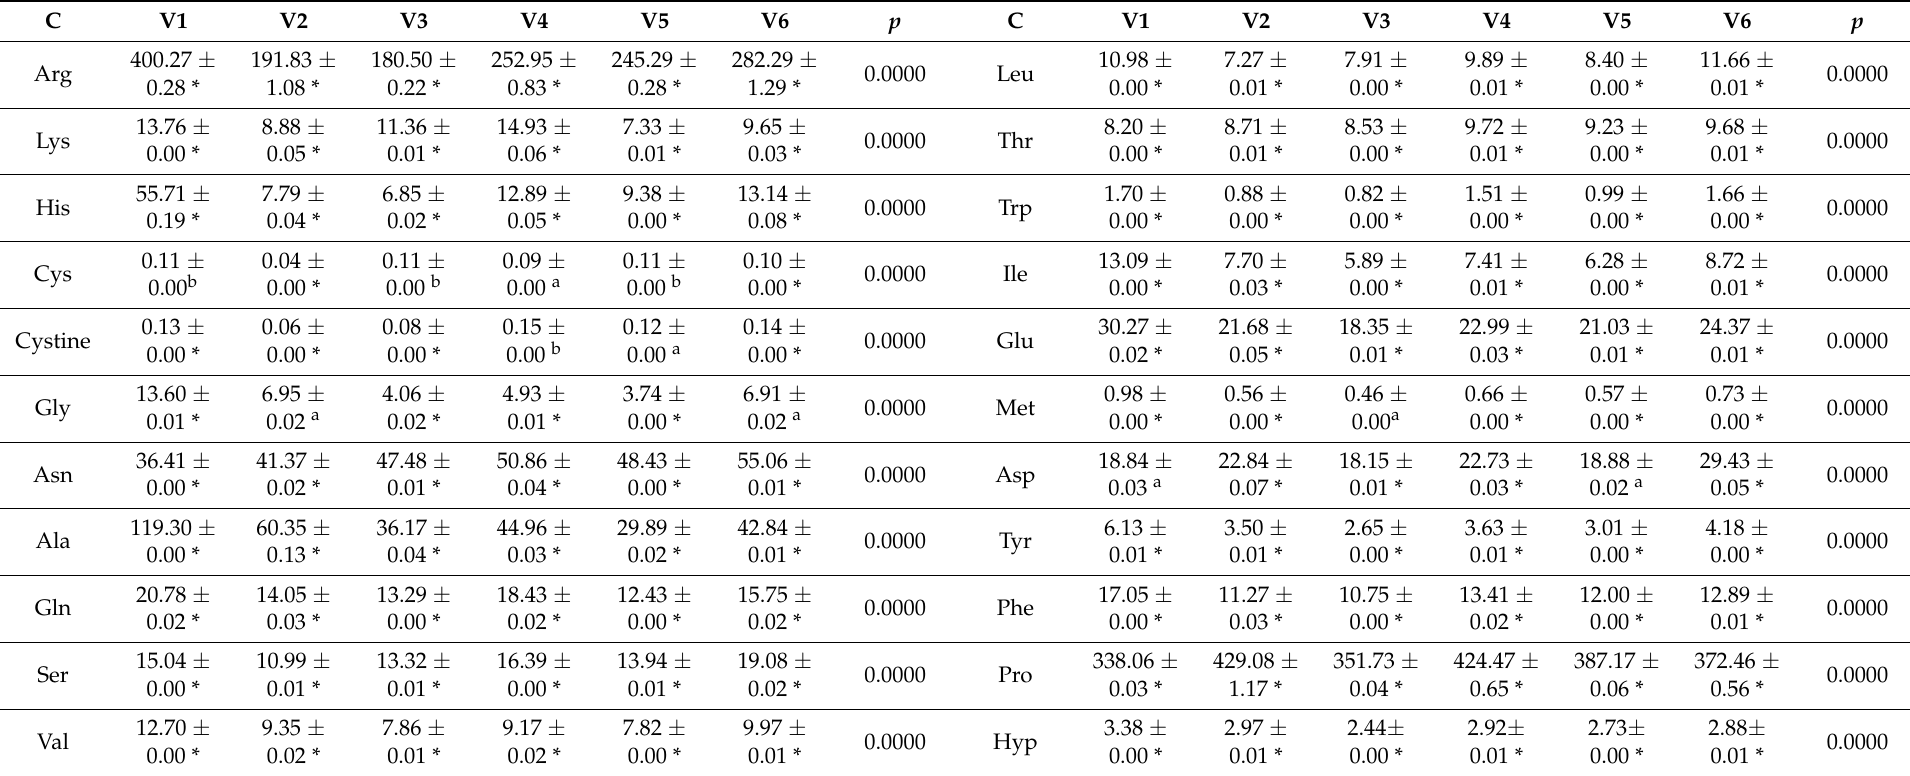
Table 1. Evaluation of some amino acid concentrations in the resulting Feteasc ă regal ă wines